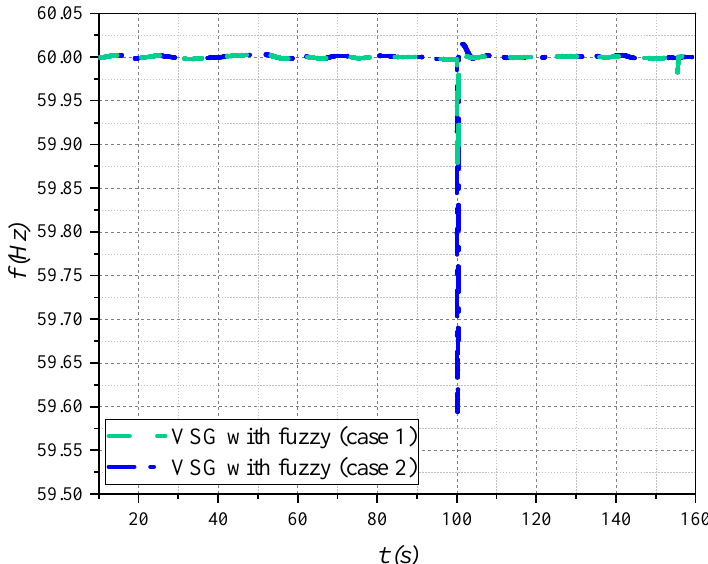
Figure 25. Microgrid frequency for the scenario presented in Section 4.2.